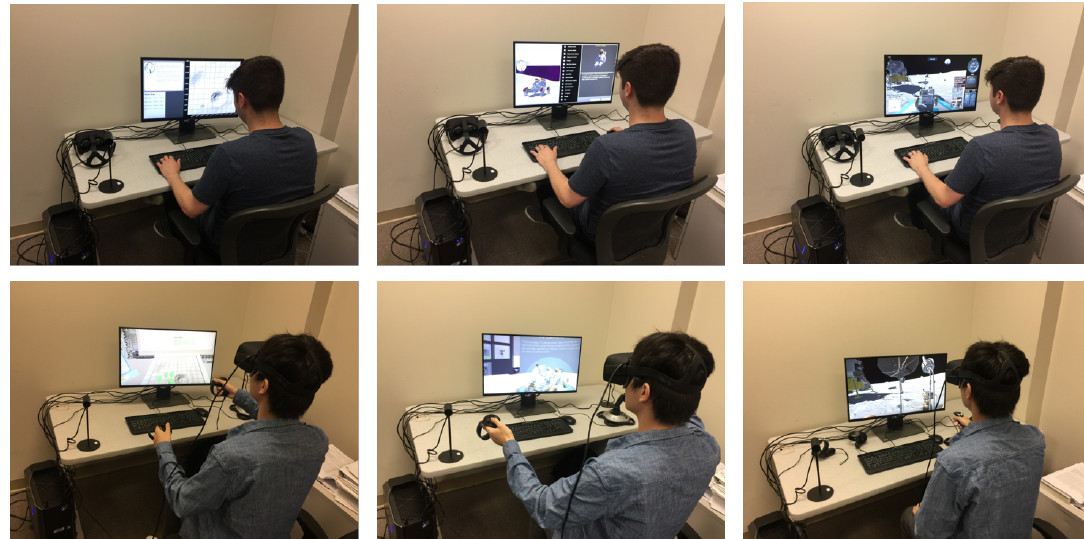
Figure 4. Pictures of participants playing the game during the usability study. The left column shows pictures of participants playing the planning phase. The middle column shows pictures of participants playing the preparing phase. The right column shows pictures of participants playing the driving phase. The first row shows participants playing the non-VR version of the game. The second row shows participants playing the VR version of the